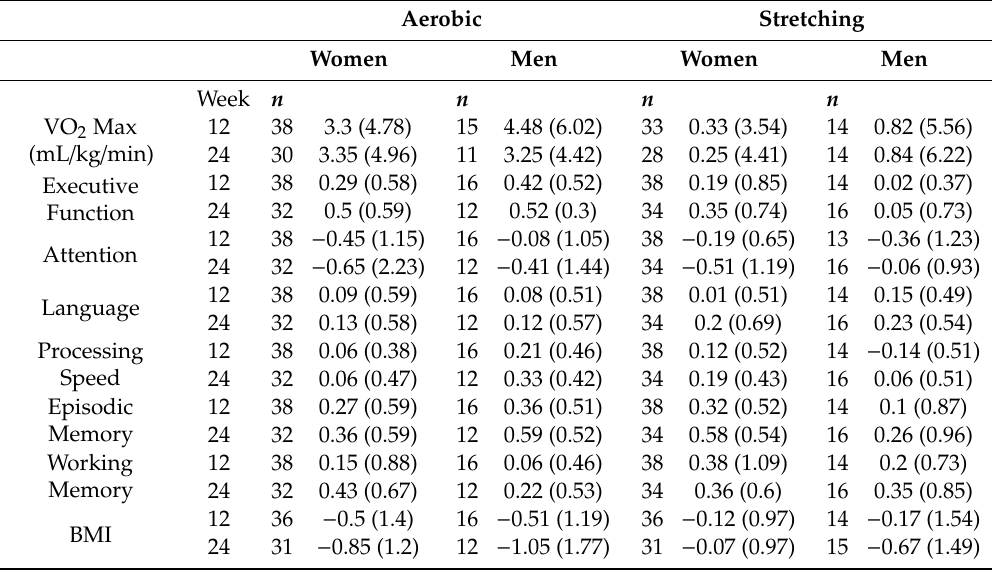
Table 2. Change from baseline to week 12 and 24 by exercise group and sex.